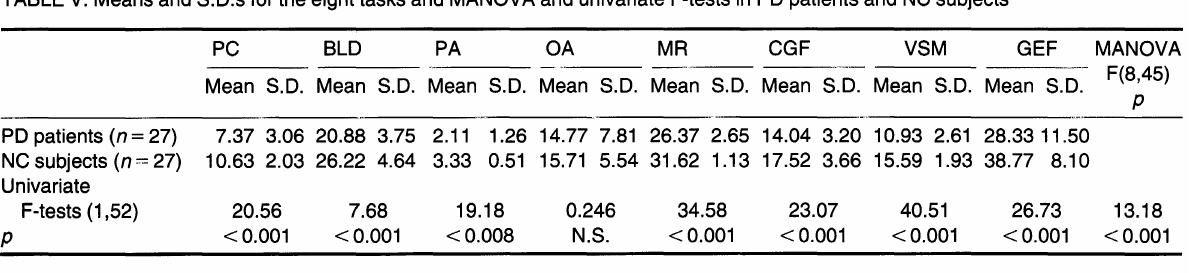
TABLE V. Means and S.D.s for the eight tasks and MANOVA and univariate F-tests in PO patients and NC